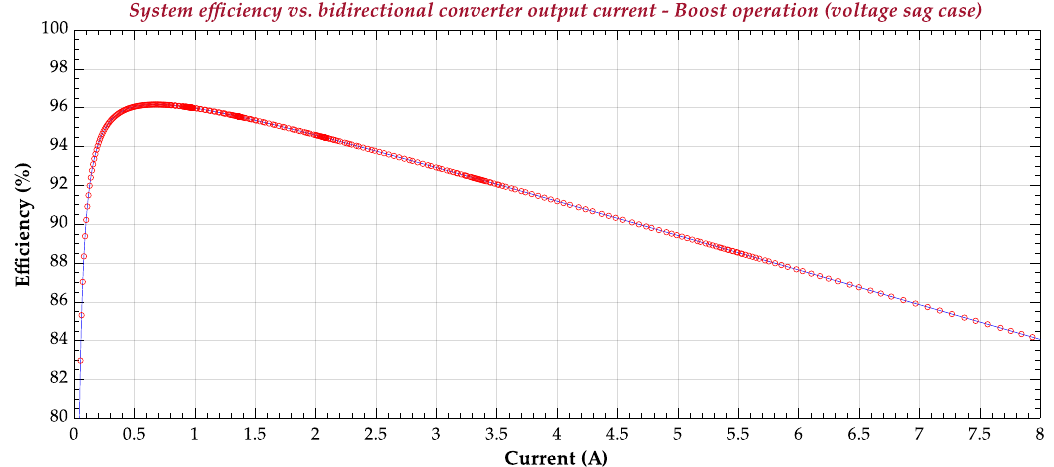
Figure 13. Estimated system efficiency for boost operation (voltage sag case), with the BBBC output current as a parameter.